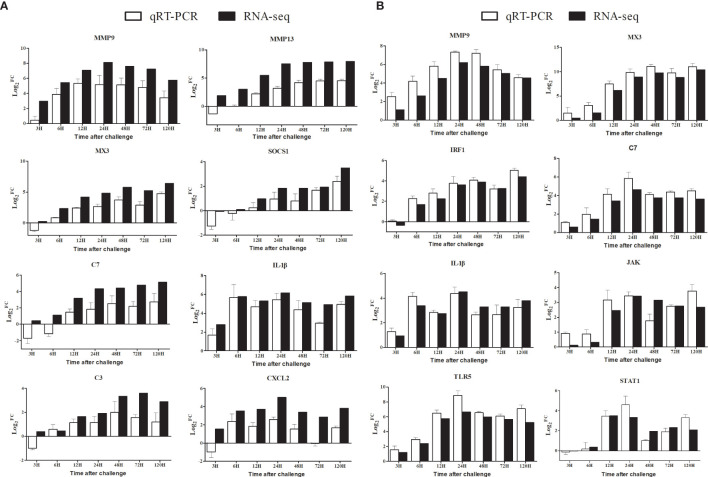
Comparison of the expression profiles of eight DEGs determined by Illumina HiSeq™ 2000 sequencing platform and qRT-PCR at 3 h, 6 h, 12 h, 24 h, 48 h, 72 h, and 120 h post-infection. Data shown are the mean of triplicates ± SD. (A): Spleen, (B): Liver.